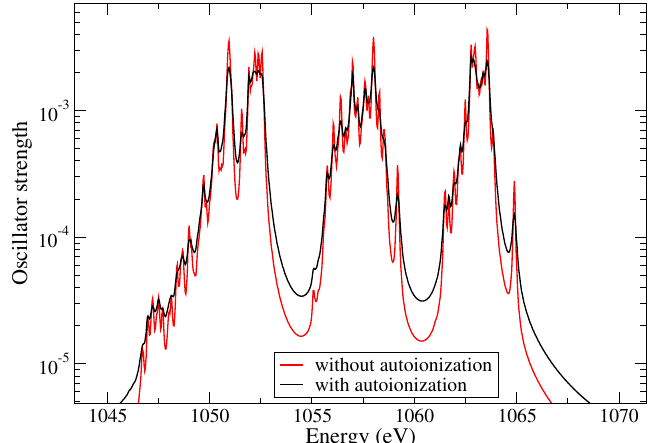
Figure 20. Transition 1 s 2 2 s 2 p 6 6 d − 1 s 2 2 s 2 p 5 4 d 6 d with and without broadening originating from autoionization process 1 s 2 2 s 2 p 6 6 d − 1 s 2 2 s 2 2 p 5 (cid:101) (cid:96)